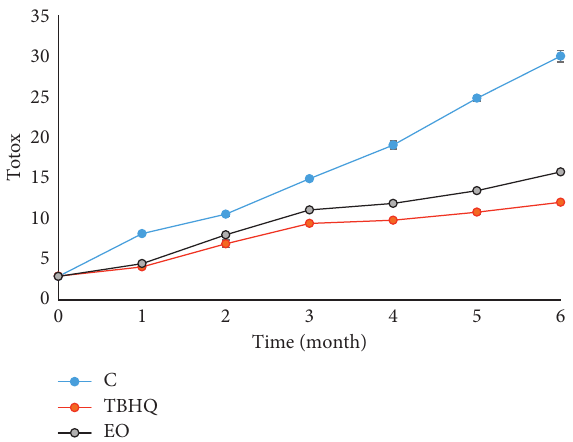
Figure 4: Totox index in different treatments of mayonnaise during 6 months. EO: sample containing Z. multiflora essential oil; TBHQ: sample containing synthetic antioxidant TBHQ; C: control sample